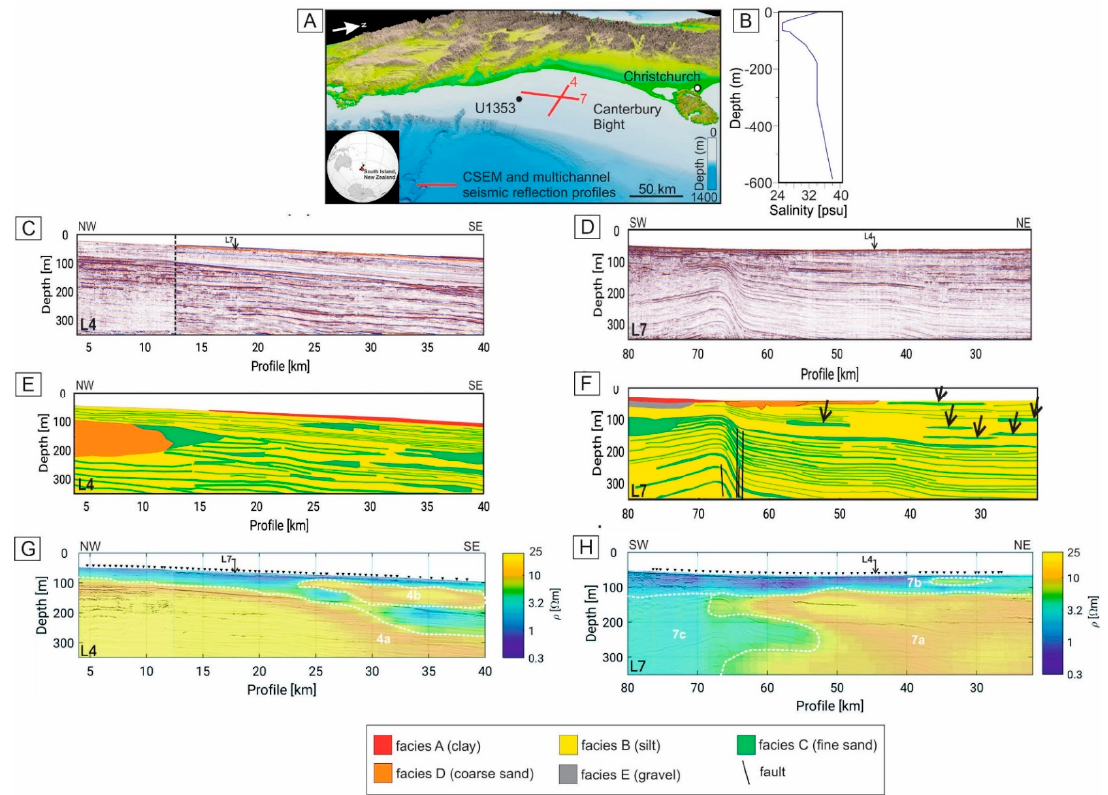
Figure 15. ( A ) Location of study area. ( B ) Variation of pore water salinity with depth, measured at IODP 317 site U1353 (location in A). ( C ) and ( D ) are the seismic reflection profiles along lines 4 and 7 (location in A). ( E ) and ( F ) are the interpreted facies in lines 4 and 7. Offsets in seismic reflectors in line 7 are marked by black lines. Black arrows denote interpreted buried valleys infilled by coarse-grained sediments. ( G ) and ( H ) are the interpreted CSEM resistivity profiles acquired along lines 4 and 7 (location in a). Black triangles mark seafloor CSEM transmitter positions on waypoints (modified from Reference [31]).